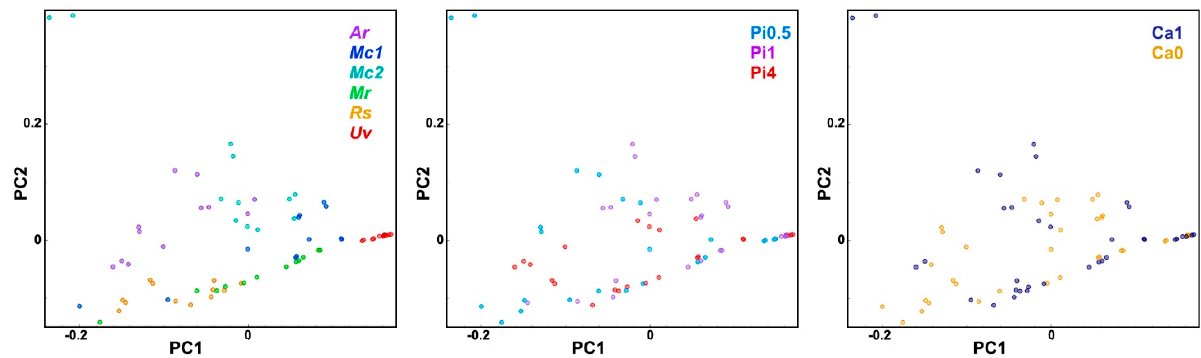
Figure 9. Multiblock or consensus principal component analysis (CPCA) of FTIR and FT-Raman spectroscopic data. Global score values of the CPCA are labeled according to strains: Amylomyces rouxii ( Ar ), Mucor circinelloides VI 04473 ( Mc1 ), Mucor circinelloides FRR 5020 ( Mc2 ), Mucor racemosus ( Mr ), Rhizopus stolonifer ( Rs ), and Umbelopsis vinacea ( Uv ) (left), phosphates concentrations (middle), and calcium availability (right). The explained variances for the first two principal components are 40.8% and 30.9%.